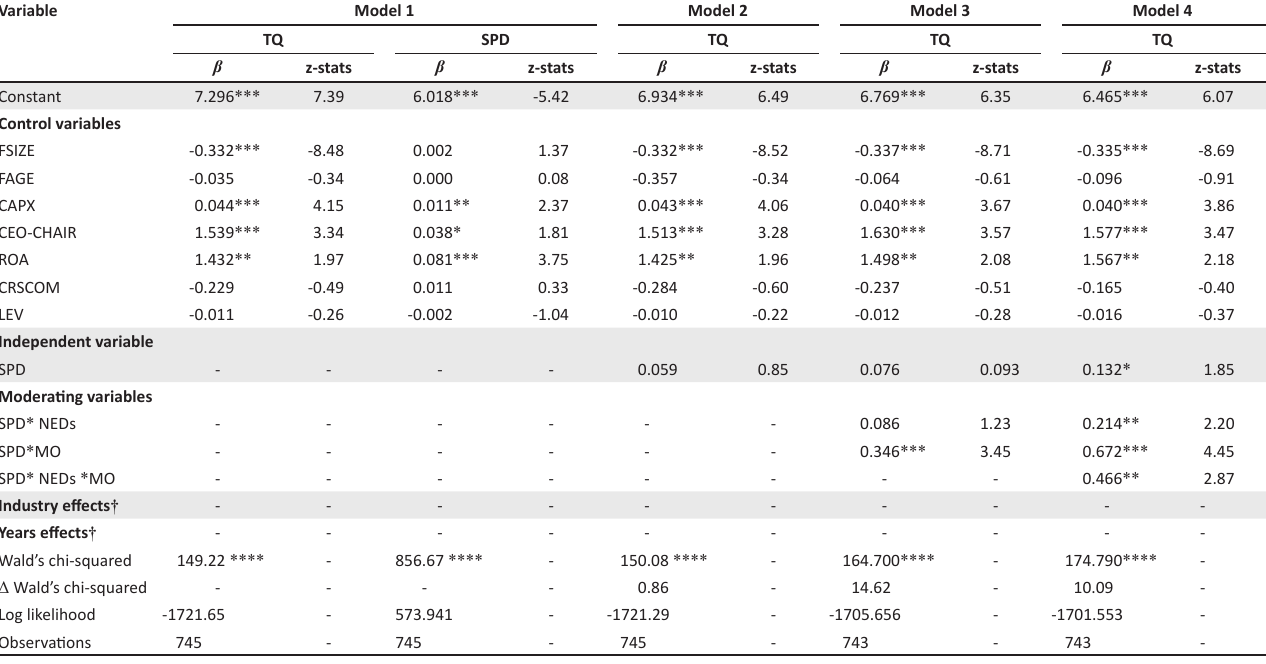
TABLE 3: Generalised least square regression results examining the moderating role of board independence and managerial ownership on the voluntary social performance disclosure and firm profitability nexus.